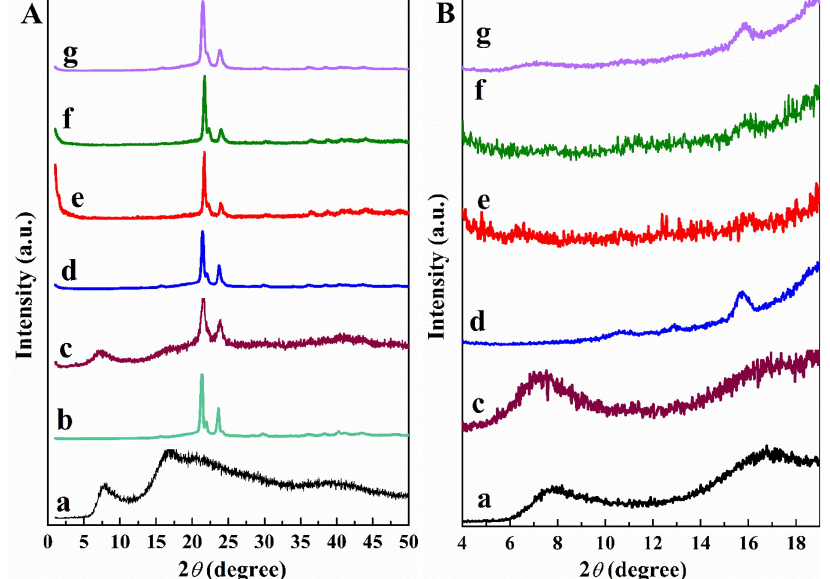
Figure 4. XRD patterns ( A ) solution blended: ( a ) APIOPOSS, ( b ) PCL-diol, ( c )